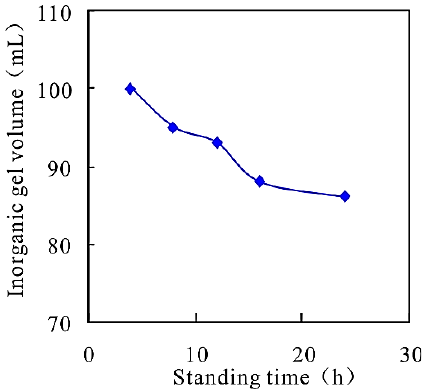
Figure 3. Relationship between standing time and inorganic gel system.